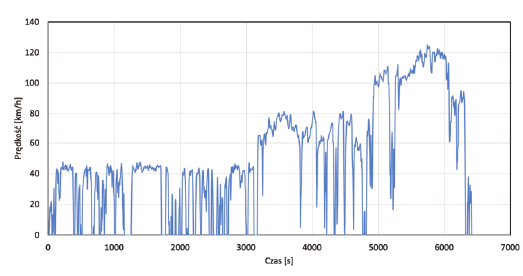
Fig. 3. The speed of the car over time Energy consumption on this c. 92 km route was tested using Yokogawa 1806E power analyser (which allows the measurement of energy consumption and energy recovery, battery charging efficiency, etc.) and Semtech DS with GPS device (measuring the length of the distance